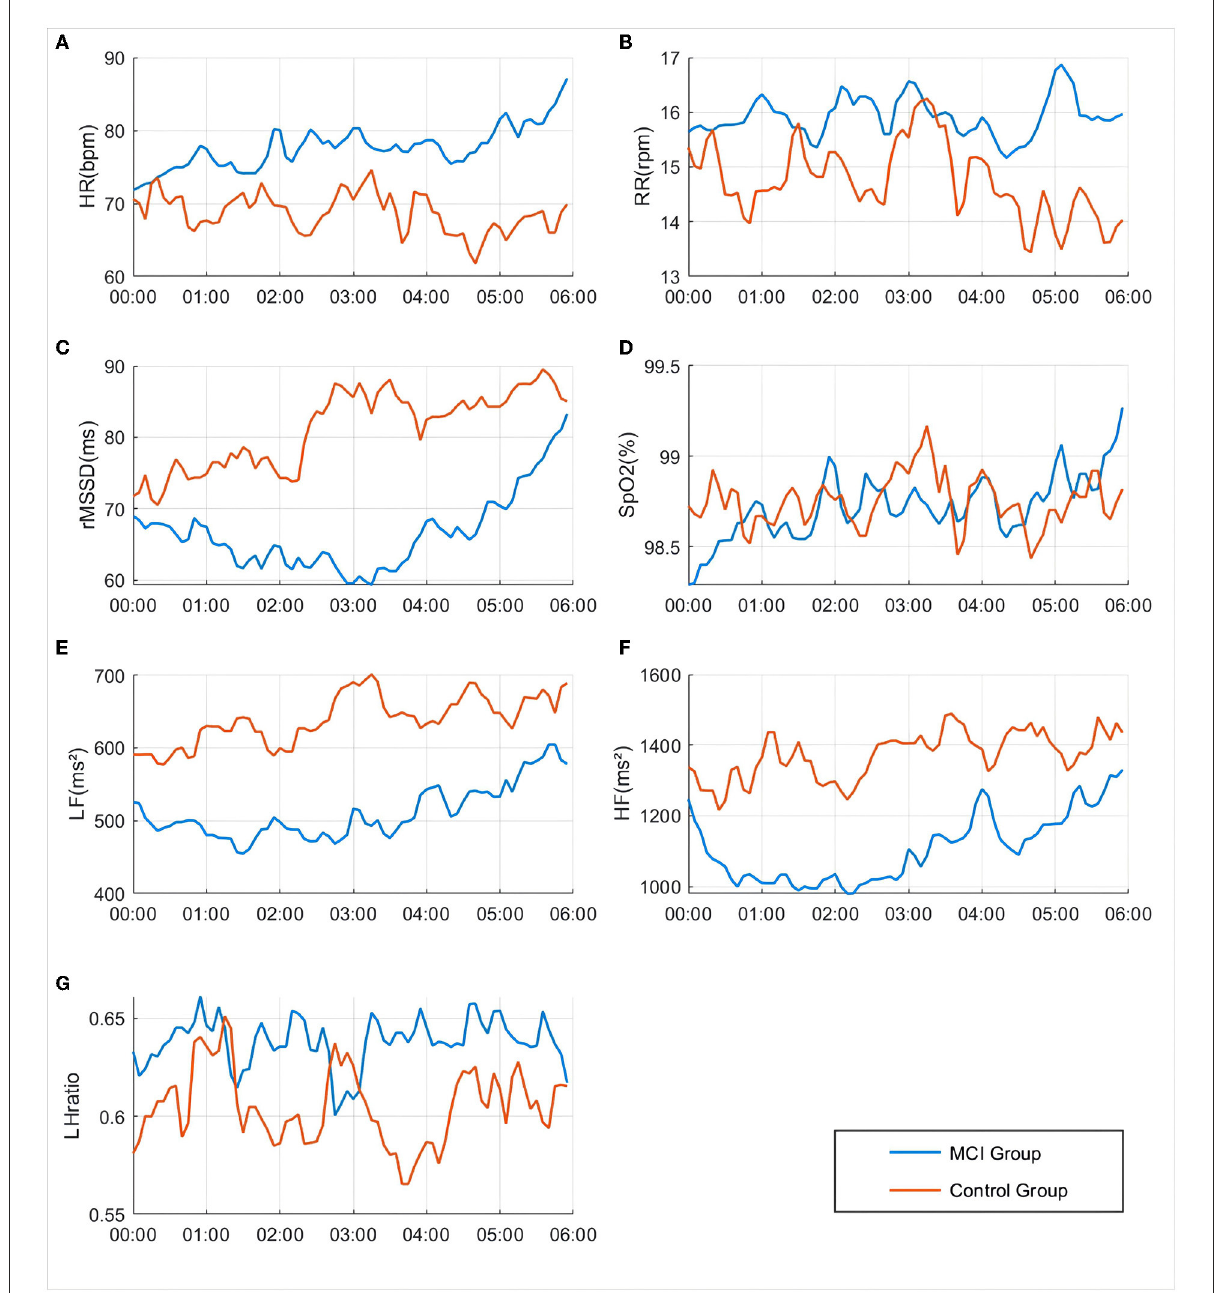
FIGURE3 Differences in changes in various physiological indicators between groups during 00:00–06:00. (A) HR: Heart rate; (B) RR: Respiratory rate; (C) rMMSD: Root mean square of the difference between adjacent pulse wave crest spacings; (D) SpO 2 : Peripheral oxygen saturation; (E) LF: Low Frequency, 0.04–0.15Hz in the pulse wave frequency band average power; (F) HF: High Frequency, 0.15–0.4Hz in the pulse wave frequency band average power; (G) LHratio: Ratio of